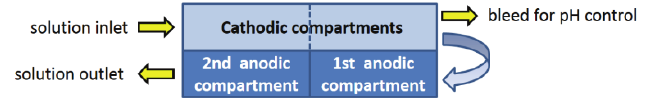
Figure 1. Schematic representation of the electrochemical reactor with four